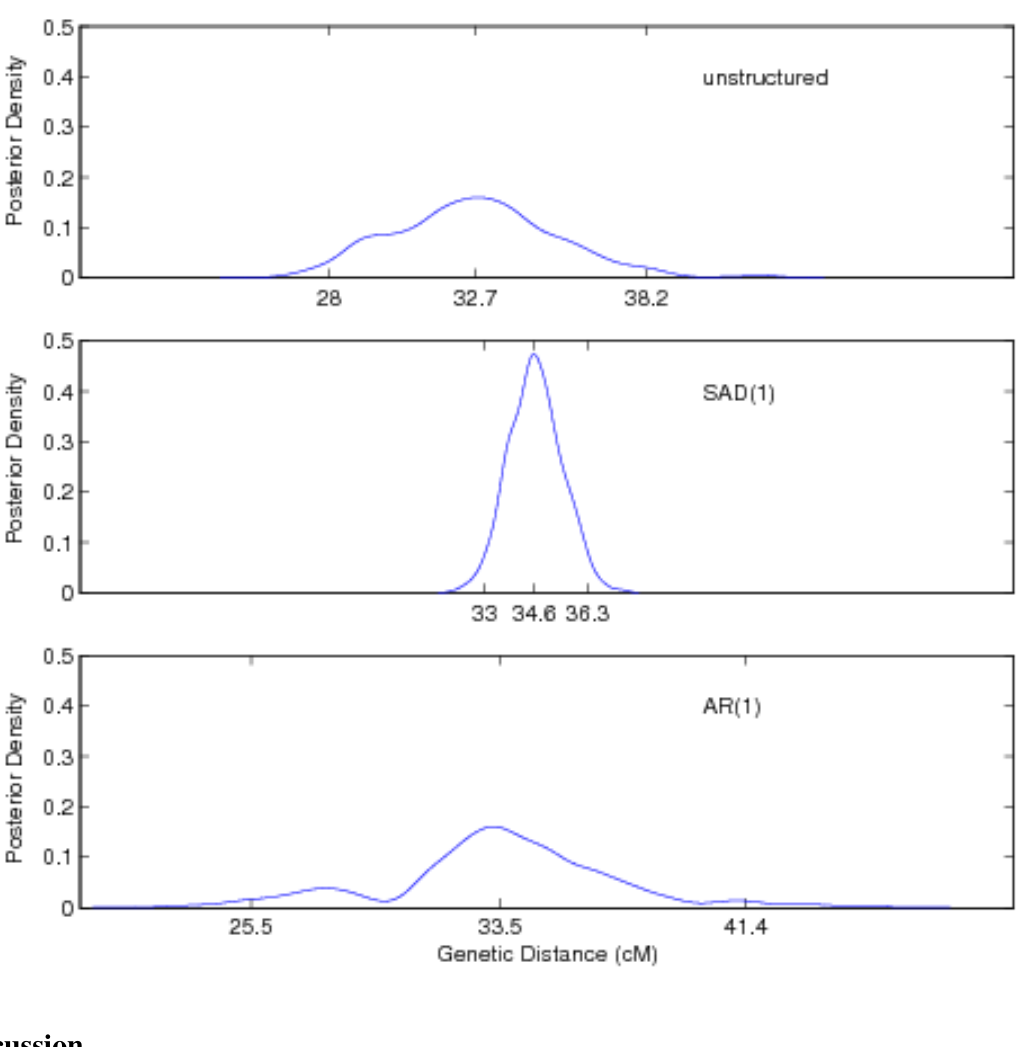
Figure 4. Estimated marginal posterior distributions of the QTL location over a simulated linkage group with different matric-structuring approaches, unstructured (top), SAD(1)- structured (middle) and AR(1)-structured